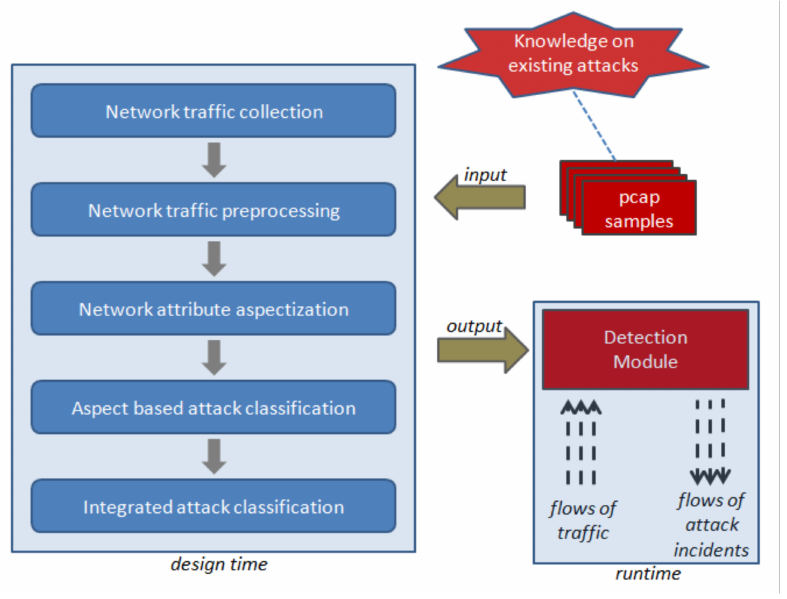
Figure 3. Scheme of the attack detection